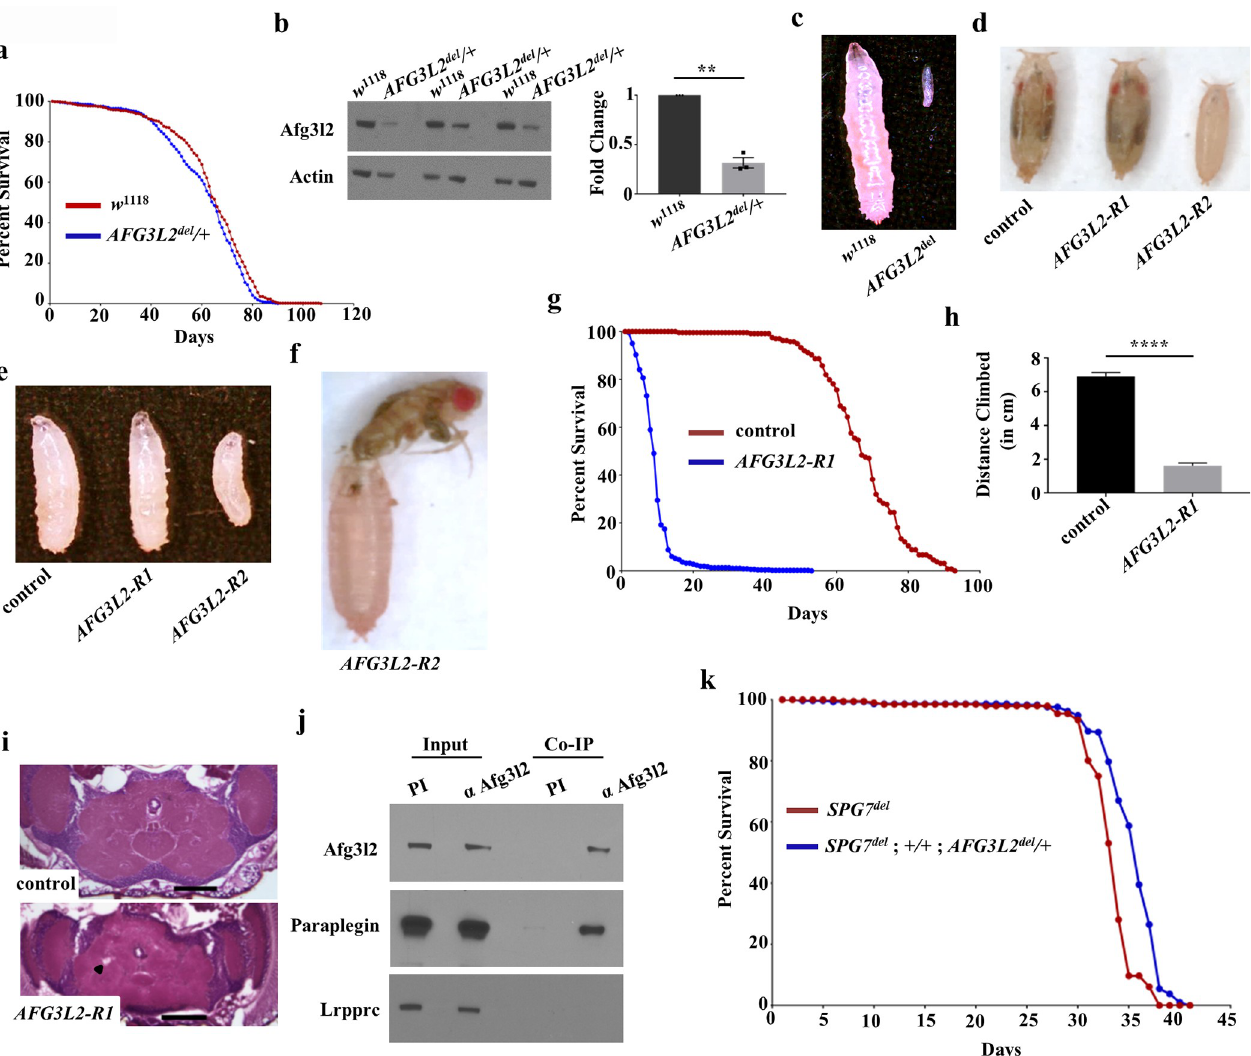
Fig 1. AFG3L2 null mutants die early in development, but neuron-specific inactivation of AFG3L2 confers shortened adult lifespan, locomotor defects, and neurodegeneration. a. Kaplan–Meier survival curves of control ( w 1118 ; N = 480, 50% survival 66 days) and AFG3L2 heterozygotes ( AFG3L2 del /+; N = 548, 50% survival 65 days). b. Western blot analysis of protein homogenates from 1-day old controls ( w 1118 ) and AFG3L2 heterozygotes ( AFG3L2 del /+ ) using antisera against Afg3l2 and actin. Afg3l2 band intensity was normalized against actin (n = 3 independent biological replicates, �� p < 0.01 by Student’s t-test). c. Size comparison of control ( w 1118 ) and AFG3L2 null homozygous larvae ( AFG3L2 del/del ) 4 days after egg hatching. d, e. Size comparison of control animals (UAS- LUCIFERASE RNAi/da-Gal4) and flies expressing RNAi lines targeting AFG3L2 in a ubiquitous manner (UAS- AFG3L2-R1 RNAi; da-Gal4 or UAS- AFG3L2-R2 RNAi/da-Gal4). Images show pupae 9 days after egg hatching (d) and larvae 4 days after egg hatching (e) . f. Pan-neuronal expression of the strong RNAi line targeting AFG3L2 (elav-Gal4; +/+; UAS- AFG3L2-R2 RNAi) resulted in the failure of flies to eclose from the pupal case. g. Kaplan–Meier survival curves of flies expressing the control LUCIFERASE RNAi (elav-Gal4; +/+; UAS- LUCIFERASE RNAi; N = 238, 50% survival 67 days) and weak RNAi line targeting AFG3L2 (elav-Gal4; UAS- AFG3L2-R1 RNAi; N = 465, 50% survival 9 days) throughout the nervous system. Significance was determined using a Mantel-Cox log-rank test ( ���� p < 0.0001). h. Climbing performance of 1-day old adult flies expressing the control LUCIFERASE RNAi (elav-Gal4; +/+; UAS- LUCIFERASE RNAi; N = 70) and the weak RNAi line targeting AFG3L2 (elav-Gal4; UAS- AFG3L2-R1 RNAi; N = 75) throughout the nervous system ( ���� p < 0.0005 by Student’s t-test). i. Hematoxylin and eosin staining of paraffin-embedded head sections from 1-day old controls (elav-Gal4; +/+; UAS- LUCIFERASE RNAi) and flies expressing the weak RNAi line targeting AFG3L2 (elav-Gal4; UAS- AFG3L2-R1 RNAi) throughout the nervous system. The black arrowhead indicates a vacuole. The scale bar is 100 μ m. j. Western blot analysis of Drosophila proteins immunoprecipitated using an antiserum against Afg3l2 ( α Afg3l2). A pre-immune serum (PI) was used as a negative control. The blot was incubated with antiserum against Afg3l2 to confirm successful immunoprecipitation of Afg3l2, and an antiserum against Paraplegin to test for co-immunoprecipitation of Paraplegin. An antiserum against Leucine-Rich Pentatricopeptide Repeat Containing (LRPPRC) protein was used as a negative control. k. Kaplan–Meier survival curves of SPG7 null mutants ( SPG7 del ; N = 196, 50% survival 34 days) and SPG7 null mutants that also bear a null allele of AFG3L2 ( SPG7 del ; +/+ ; AFG3L2 del /+ ; N = 291, 50% survival 36 days).